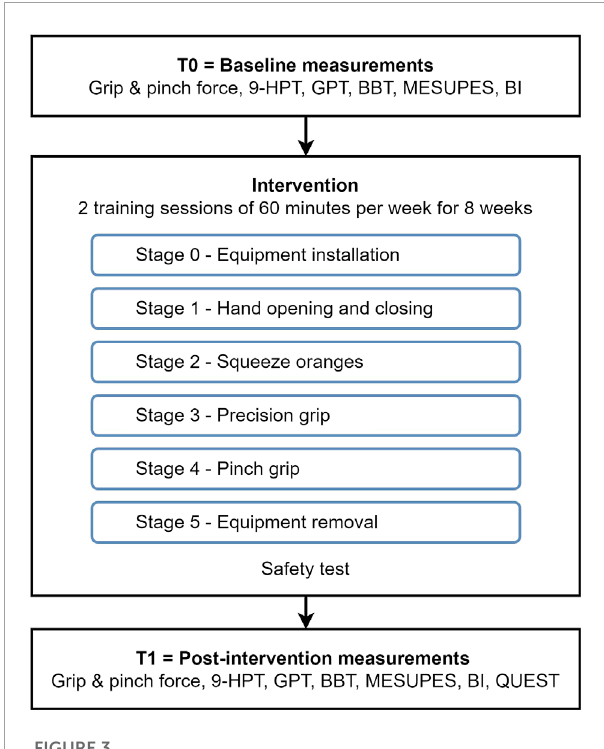
FIGURE 3 Flow diagram of the stages of the intervention and baseline and post intervention manual function